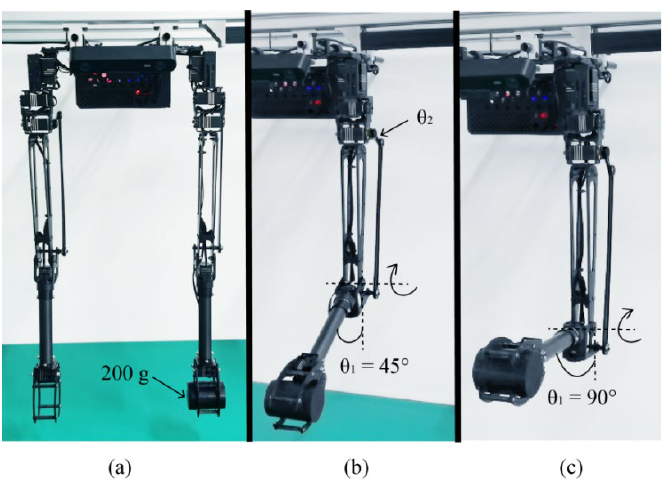
Figure 7. Lift load test of single manipulator when the external load is 200 g: ( a ) θ 1 = 0 ◦ ; ( b ) θ 1 = 45 ◦ ; ( c ) θ 1 = 90 ◦